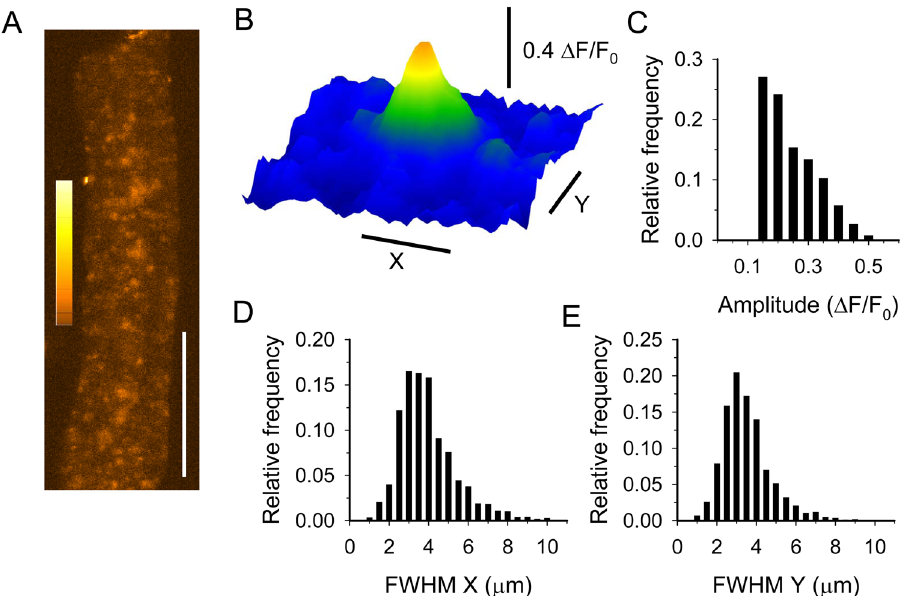
Figure 2. Spontaneous elementary calcium release events in two dimensional (XY) experiments. ( A ) Sum of 30 background corrected images of a Fluo-8 loaded fibre representing 30 s. ( B) A representative spark. Histograms of parameters of calcium sparks: amplitude ( C ), FWHM perpendicular (D) and parallel (E) to the fibre axis. Calibration on panel A is 50 µm. Calibrations on panel B are 5